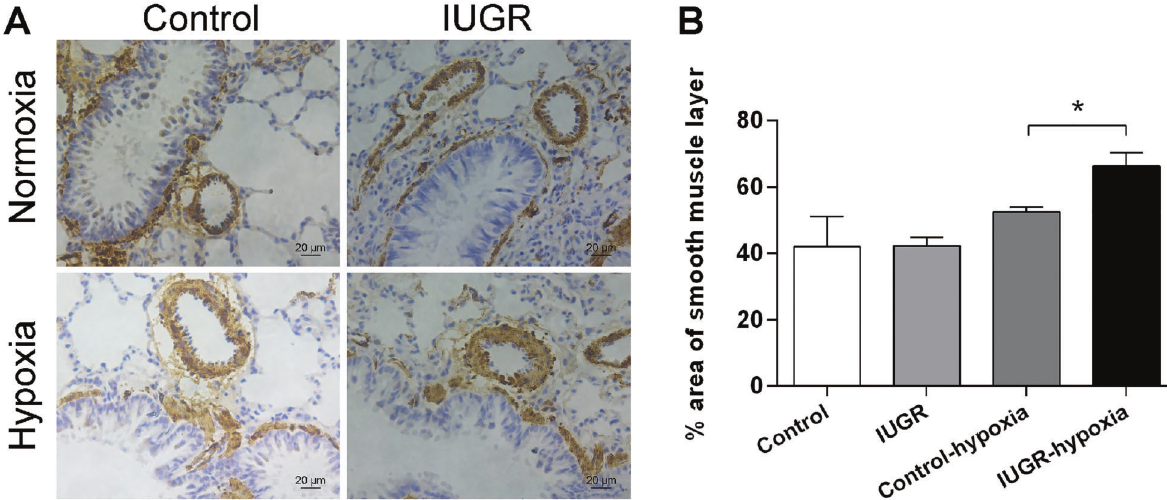
Figure 2. Remodeling of resistance pulmonary artery (PA) ring smooth muscle layers of intrauterine growth retardation (IUGR)-hypoxia and control-hypoxia rats. A , Representative immunohistochemical staining images of smooth muscle layers of resistance PAs. Brown indicates a -SMA (smooth muscle actin). Scale bar=20 m m. B , Summary histogram of immunohistochemical staining images of the smooth muscle layer of all groups. The smooth muscle layer of resistance PA rings is thicker in IUGR rats than in control rats after 2 weeks of hypoxia. Data are reported as means ± SD. *P o 0.05 (ANOVA).